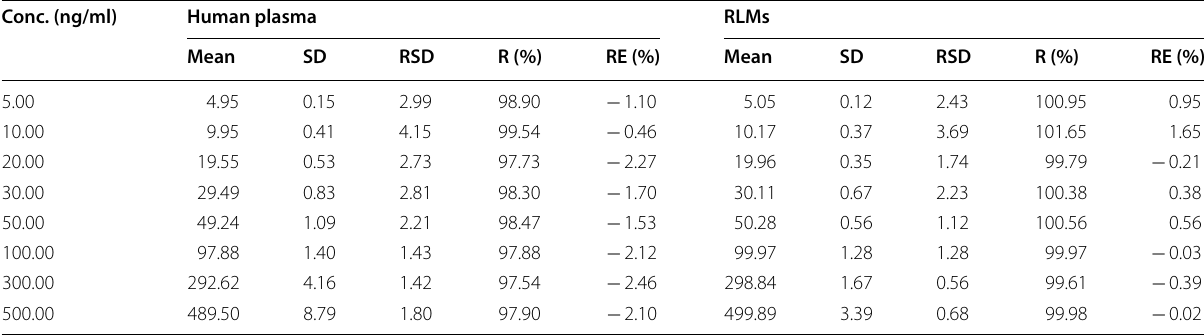
Table 1 Back calculation of conivaptan Conc. (ng/ml)